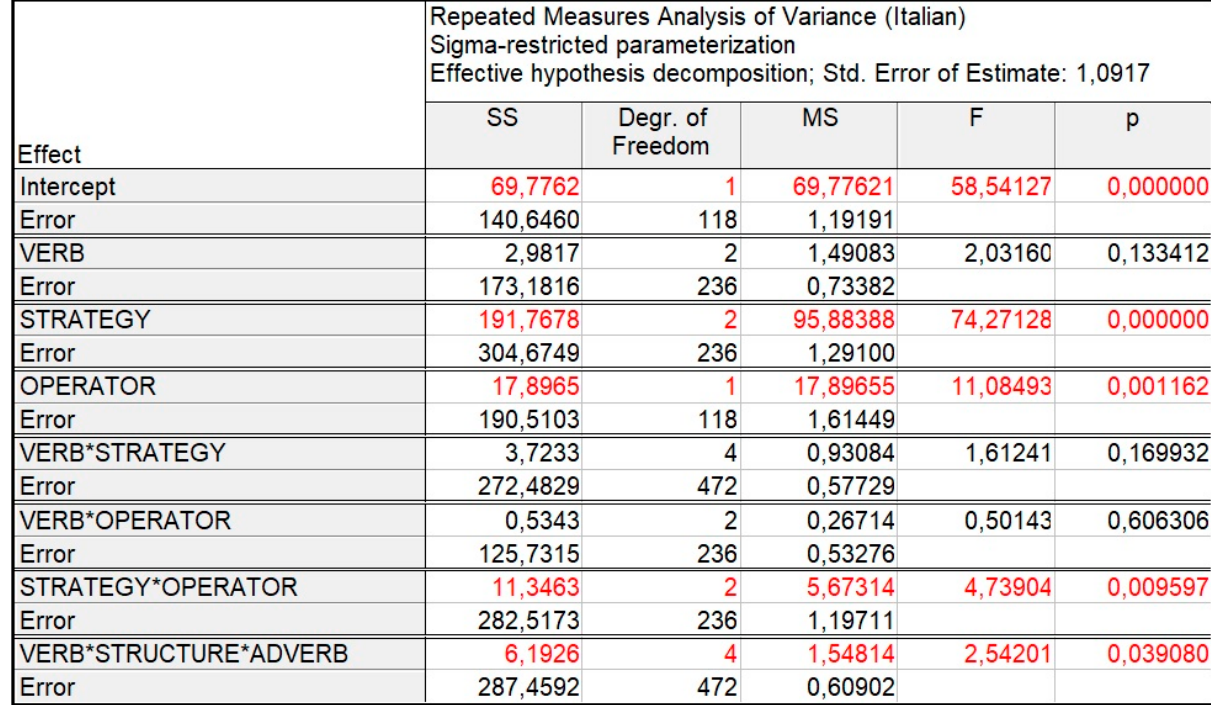
Figure 15. Three factors’ post hoc results (Italian) 19 .